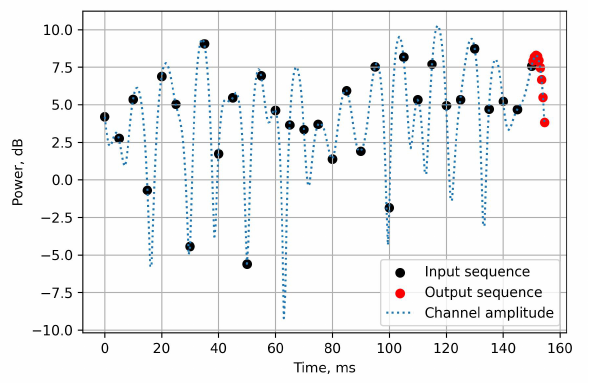
Figure 3. Sample data for PABAFT